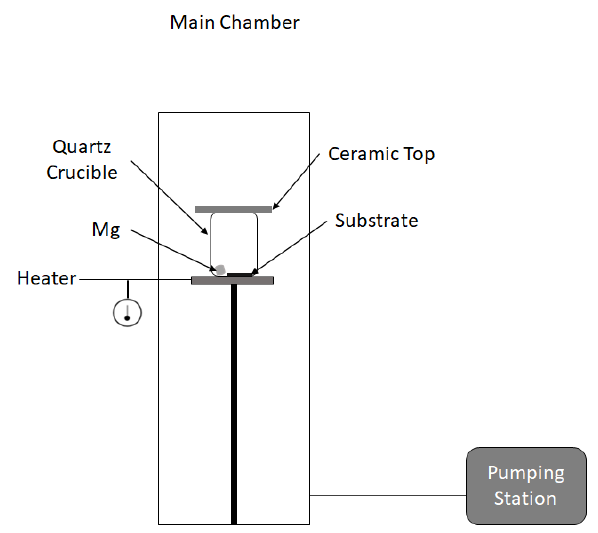
Figure 1. Vacuum chamber used for sublimation deposition of Mg onto silica nanosprings. The sample and Mg pellets are placed in a quartz crucible capped with a ceramic disk.